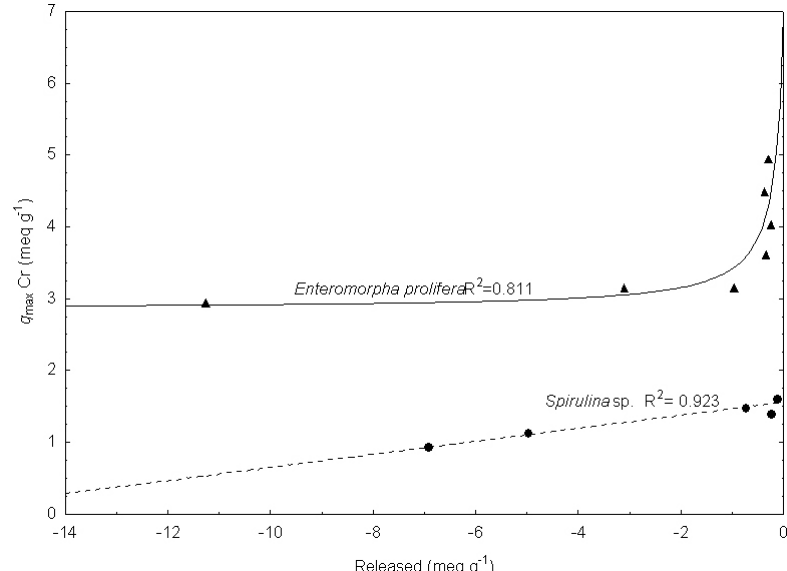
Figure 3. The dependence of q